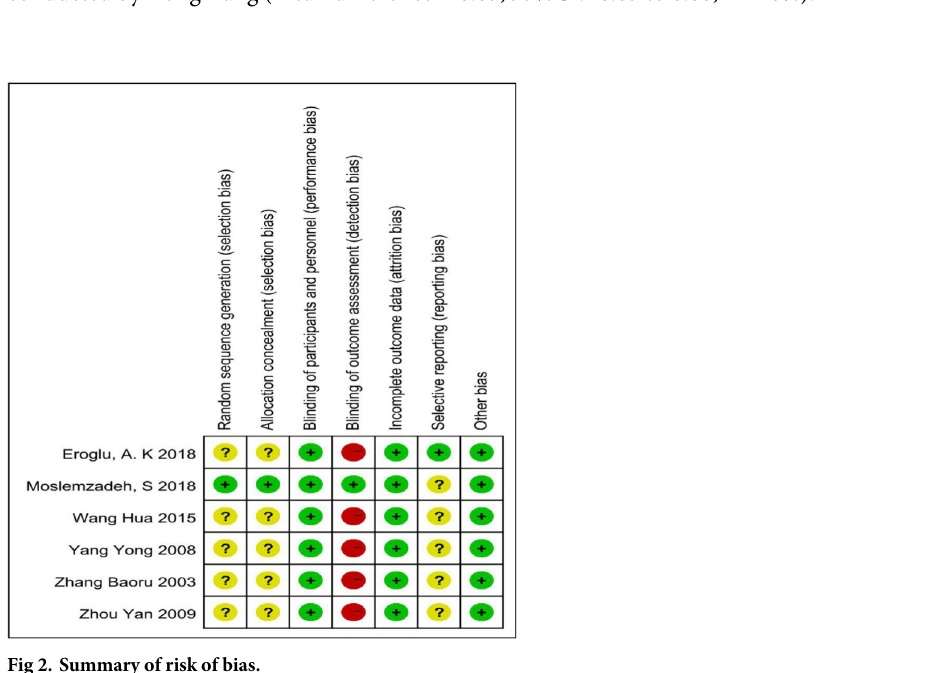
The results of the meta-analysis (random-effects model) showed that there were significant dif- ferences in GI between the VFR group and the Hawley group, including at 1 month (mean dif- ference = 0.12, 95%CI: 0.06 to 0.19) and 3 months (mean difference = 0.11, 95%CI: 0.06 to 0.17). At 6 months (mean difference = 0.10, 95% CI: -0.07 to 0.27), there was no significant dif- ference. As shown in Fig 4, there was a great heterogeneity in GI at the 6th month (I2 = 80%). The greater heterogeneity may be due to Yong Yang’s subjective reasons at the time of mea- surement. As shown in Fig 5, heterogeneity was significantly reduced after excluding the study conducted by Yong Yang (mean difference = 0.03, 95%CI: -0.03 to 0.08, I2 = 0%).